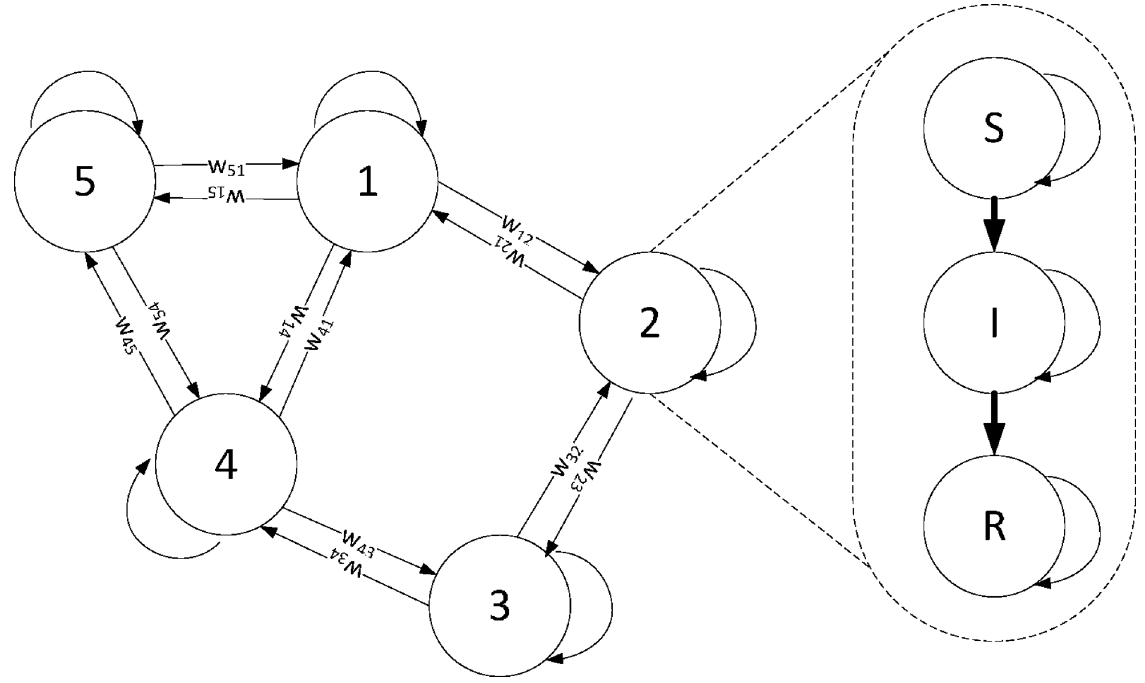
Figure 1. A toy example of infectious disease spread in a five node network. Each node represents a physical location associated with an inhomogeneous Poisson process shown as an example for node 2. Each edge is associated with w ij measuring the spreading trend from node i to node j .